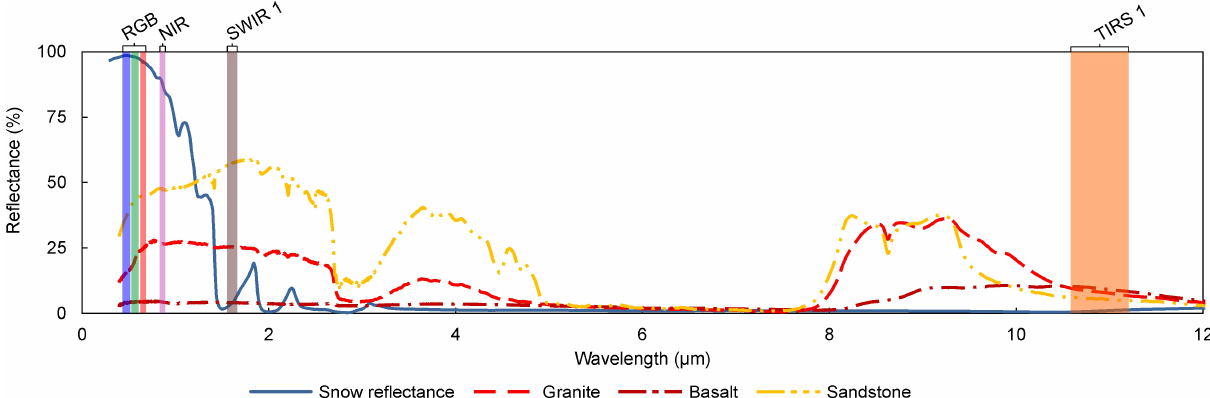
Figure 2. Spectral reflectance data for snow and rock (granite, basalt and sandstone) from the ASTER Spectral Library v1.2 (Baldridge et al., 2009). Designations of spectral regions as defined by the Landsat 8 bands: blue – band 2, 0.45–0.51µm; green – band 3, 0.53–0.59µm; red – band 4, 0.64–0.67µm; NIR, near infrared – band 5, 0.85–0.88µm; SWIR 1, shortwave infrared – band 6, 1.57–1.65µm; TIRS 1, Thermal Infrared Sensor 1 – band 10, 10.60–11.19µm.